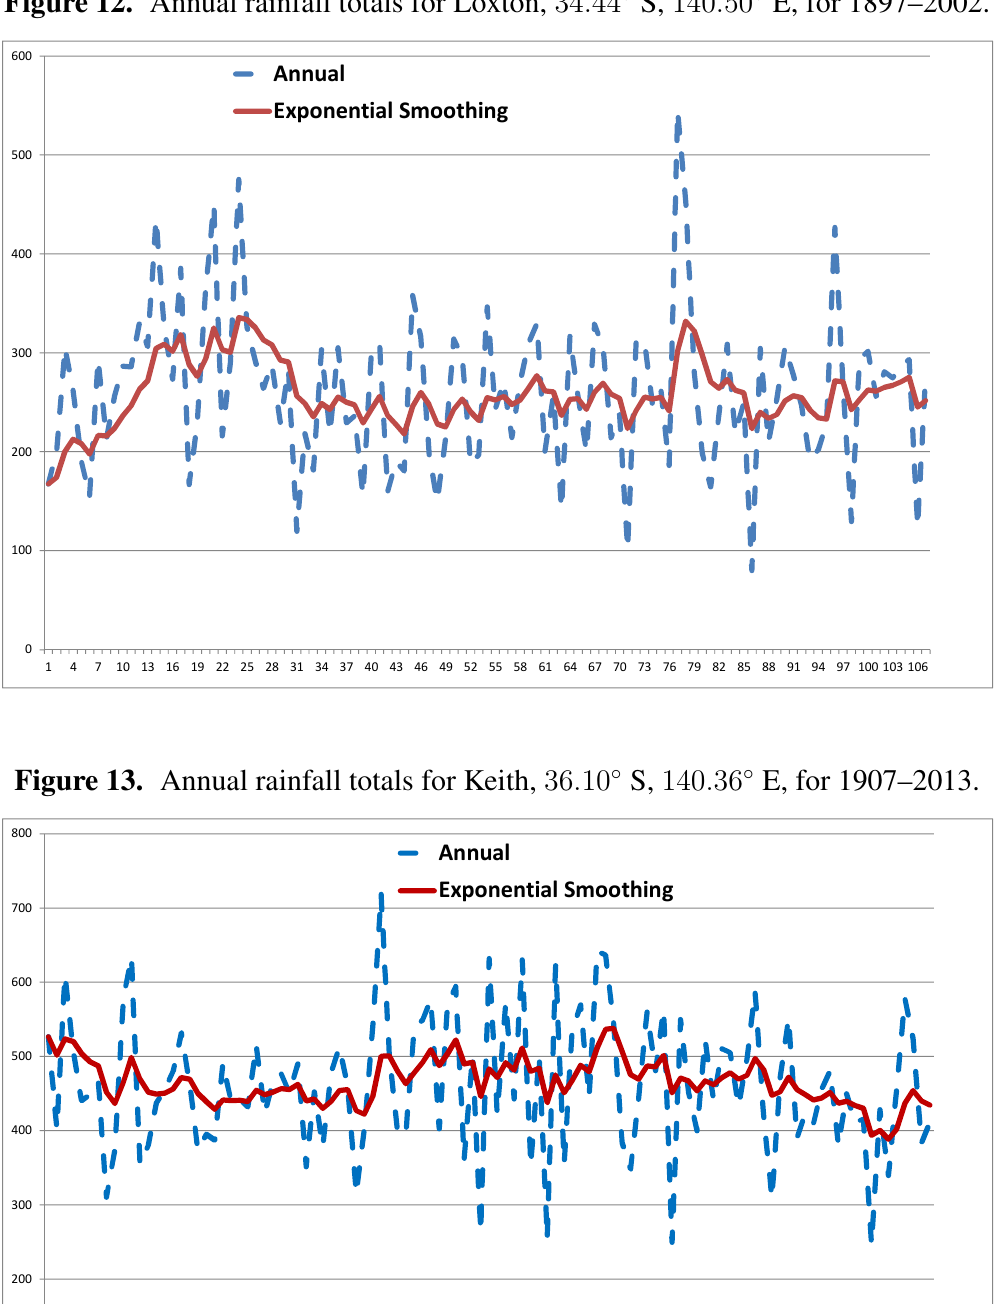
Figure 12. Annual rainfall totals for Loxton, 34 . 44 ◦ S, 140 . 50 ◦ E, for 1897–2002.